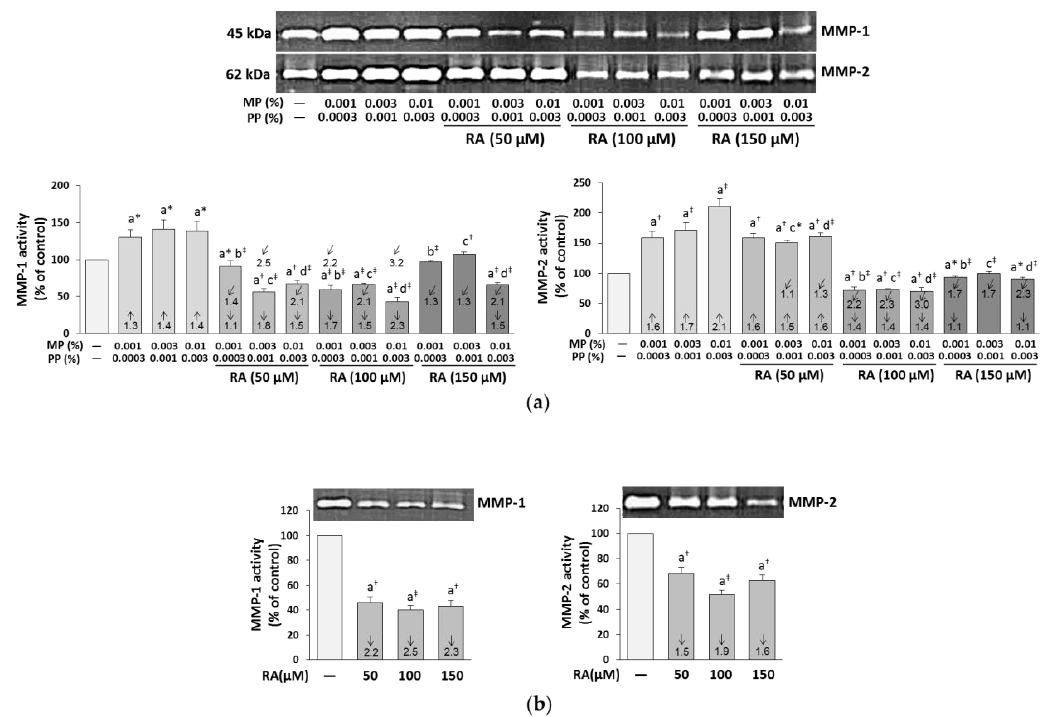
Figure 8. The influence of rosmarinic acid (RA) on the activity of matrix metalloproteinases (MMP-1 and MMP-2) in the fibroblasts treated with methylparaben (MP) and n-propylparaben (PP) ( a ) and untreated cells ( b ). Representative gels of zymography, the intensity of the enzyme bands was quantified by densitometry, values represent the mean (% of control) ± SD of three experiments. Statistically significant differences are marked as: a vs. control, b vs. 0.001% MP and 0.0003% PP, c vs. 0.003% MP and 0.001% PP, d vs. 0.01% MP and 0.003% PP; * p < 0.05; † p < 0.01; ‡ p < 0.001. The values in the bars show a factor of change in comparison to the control ( ↑ , increase; ↓ , decrease) or to the respective samples treated with parabens alone (MP and PP) ( ↙ , decrease).